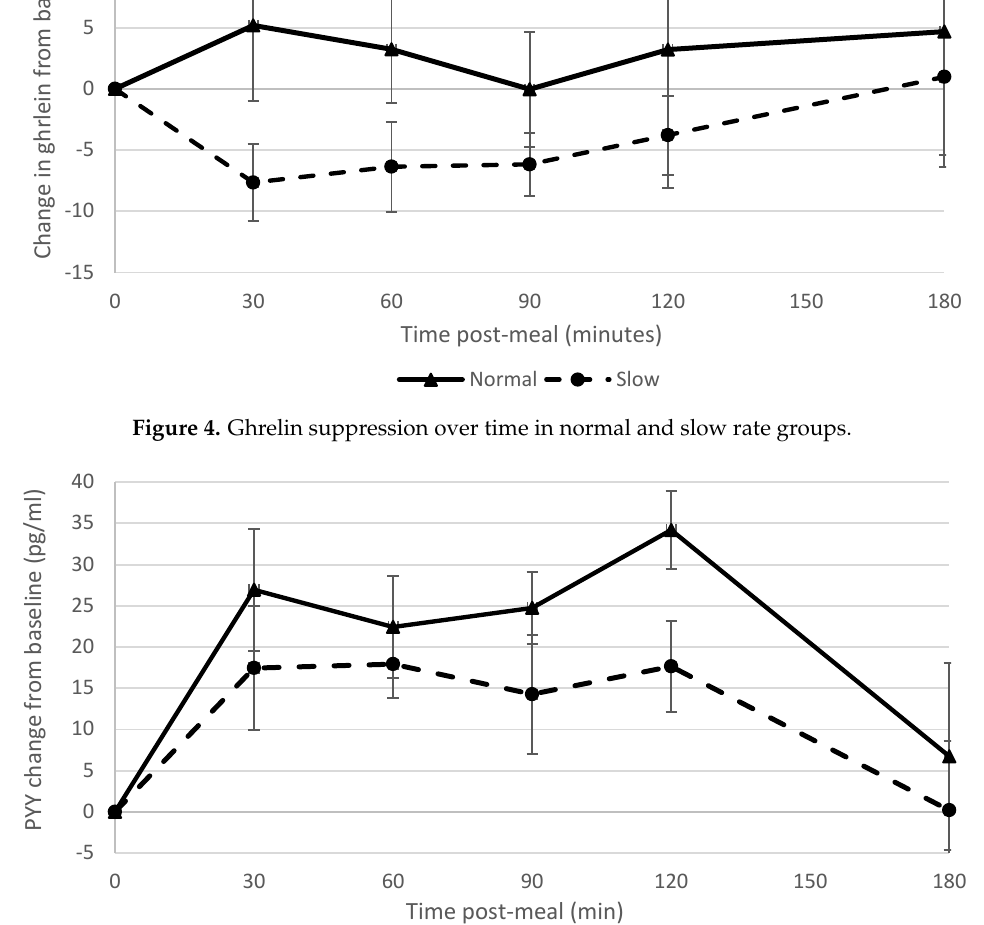
Figure 4b. PYY change over time in normal and slow rate groups.